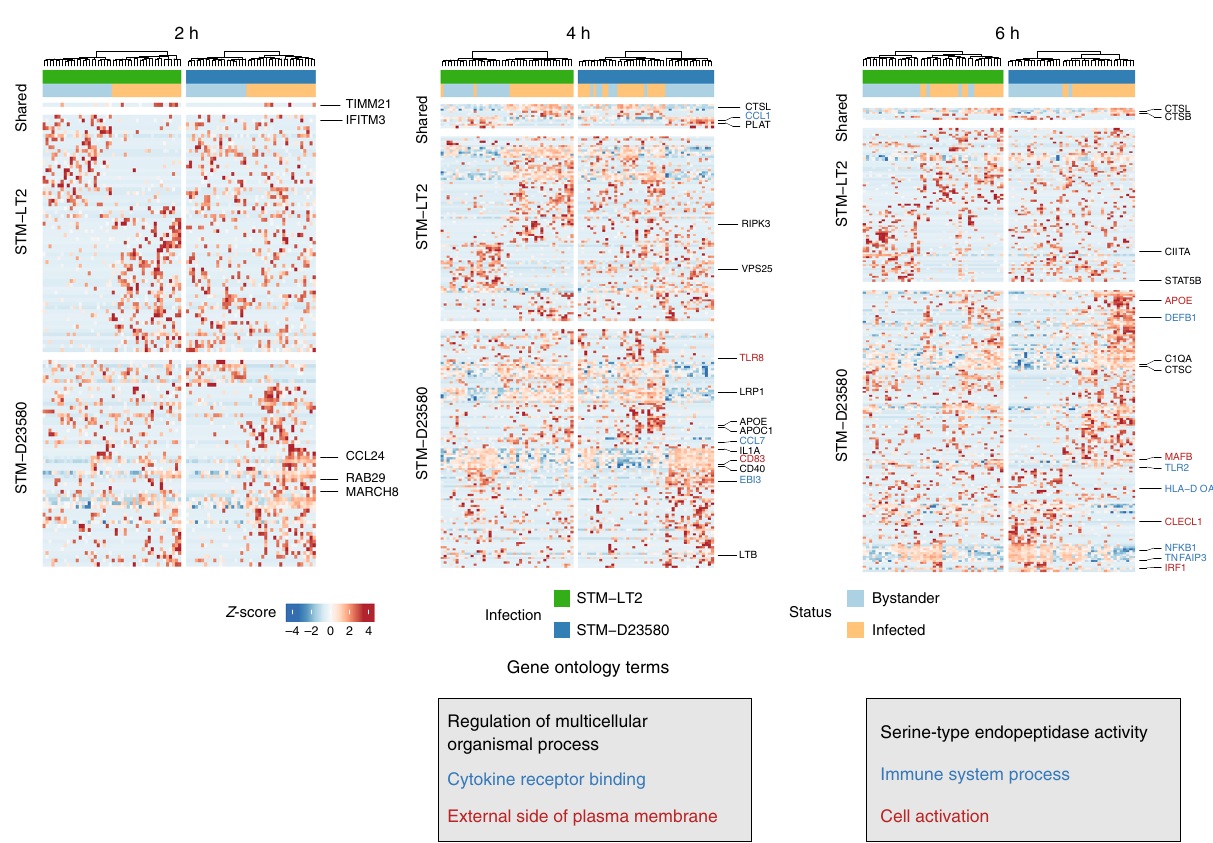
Fig. 3 STM-D2350 and STM-LT2 induce divergent single-cell pro fi les in infected and bystander cells. Heat maps displaying signi fi cant DE genes ( P -value < 0.01) identi fi ed between infected and bystander cells at time points 2, 4 and 6 h p.i, respectively. Rows and columns were clustered using Euclidian distance and Ward ’ s clustering criterion applied to the row-scaled log-transformed normalized counts across all heat map panels at that time point. Enriched GO categories and associated genes are indicated by